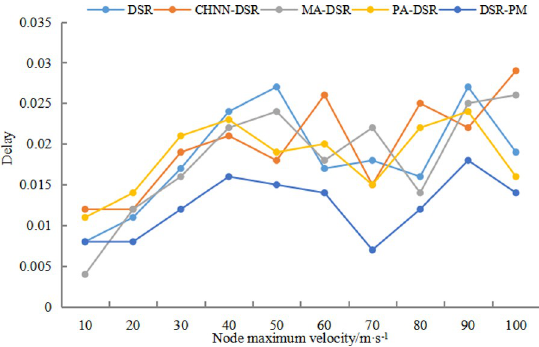
Fig 7. Delay comparison